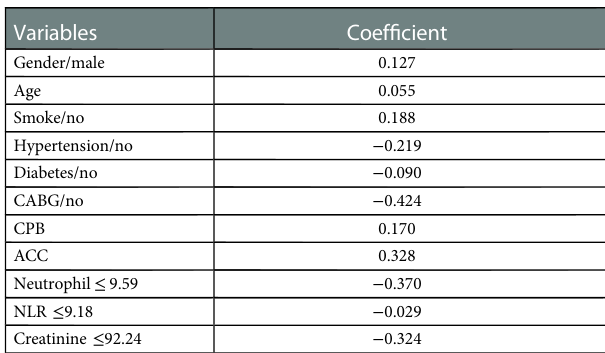
TABLE 3 Risk factors selected by the LASSO-logistic regression